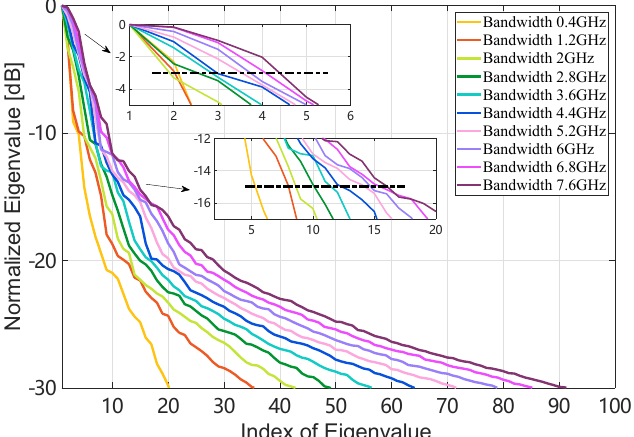
Figure 8. The normalized eigenvalues versus eigenvalue index obtained for different bandwidths at Position 2.